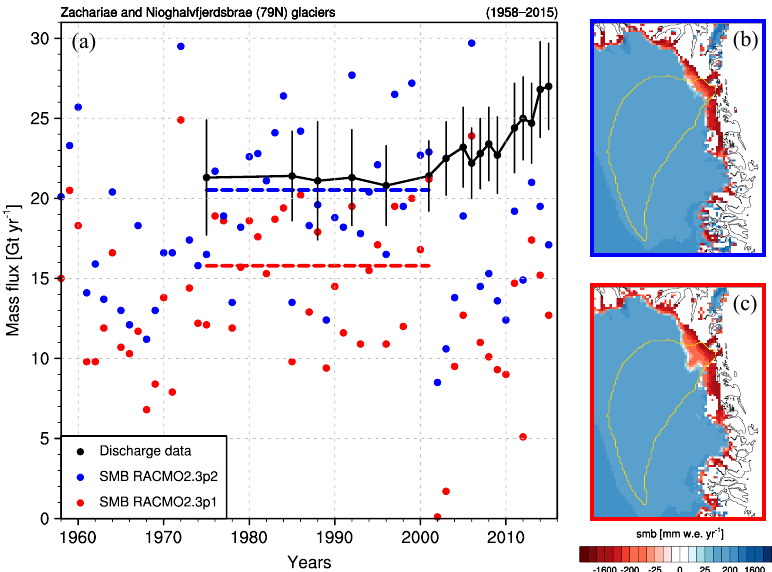
Figure 8. (a) Modelled basin-integrated SMB in RACMO2.3p2 (blue dots) and RACMO2.3p1 (red dots) and ice discharge estimates (black dots, Mouginot et al., 2015) from the glacier basins of Zachariae Isstrøm and Nioghalvfjerdsbrae (79 ◦ N) in north-eastern Greenland (yellow line in b and c ) for the period 1975–2015. Dashed lines represent average SMB for 1975–2001. Mean SMB as modelled by (b) RACMO2.3p2 and (c) RACMO2.3p1 in north-eastern Greenland for the period 1958–2015. Table 6. Modelled and observed mean annual SMB (mw.e.yr − 1 ) and statistics of the differences at S4, S5, SHR, S6, S7, S8 and S9 over 1991–2015; measurements at S10 are compared to modelled total precipitation minus melt for the period 1994–2015. Spatial coordinates of each site are listed. Stakes Observed RACMO2.3p1 RACMO2.3p2 Coordinates SMB mean bias RMSE R 2 bias RMSE R 2 long. lat. elevation ( ◦ W)